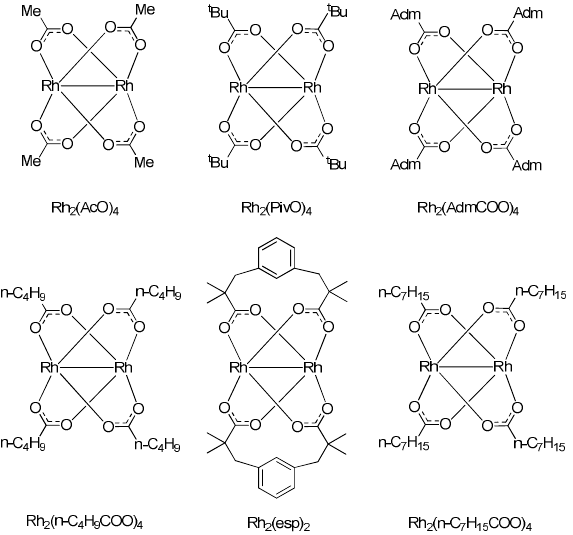
Figure 3. Rh(II) catalysts investigated for the influence of catalyst loading on the product composition.